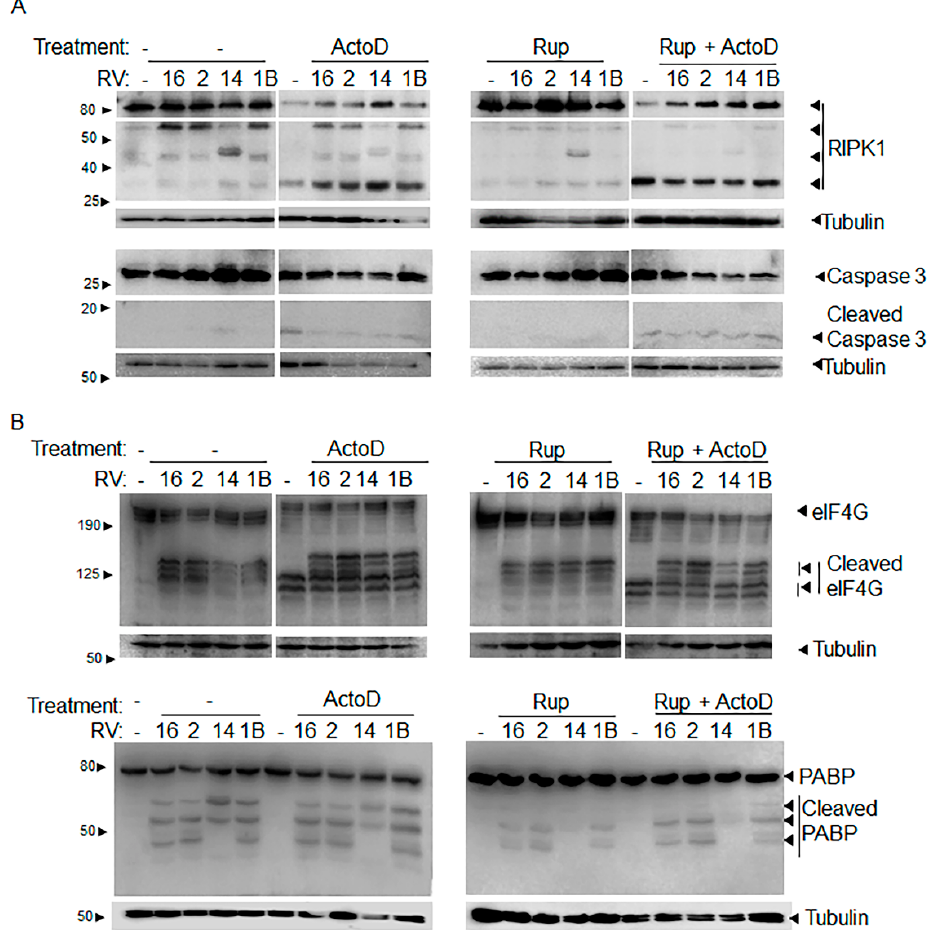
Figure 3. Inhibition of 3Cpro abrogates cleavage of RIPK1. O-HeLa cells were infected with the RV strain indicated at an M.O.I. of 3, for 1 h of adsorption and then a further 12 hpi. At 3 hpi, cells were treated with ActoD (5 µg/mL) or remained untreated, and at 9 hpi, cells were treated with Rupintrivir (1 µM) or remained untreated. Protein lysates were subject to SDS-PAGE, transferred to nitrocellulose membrane and blocked. Blots were probed with ( A ) anti-RIPK1 antibodies (upper blot), anti-caspase 3 antibodies (middle blot), ( B ) anti-eIF4G antibodies (upper blot), anti-PABP antibodies (lower blot). Tubulin was used as a loading control for all blots, and is included below the corresponding blots in ( A , B ). The position of bands correlating to the indicated full-length protein, or the cleavage products are indicated to the right of the blot. The relevant molecular weights are indicated to the left of the blots. Representative western blots of three independent experiments have been shown. Please note that proteins were separated on 12.5% (RIPK1, PABP blots) or 8% (eIF4G blot) gels.